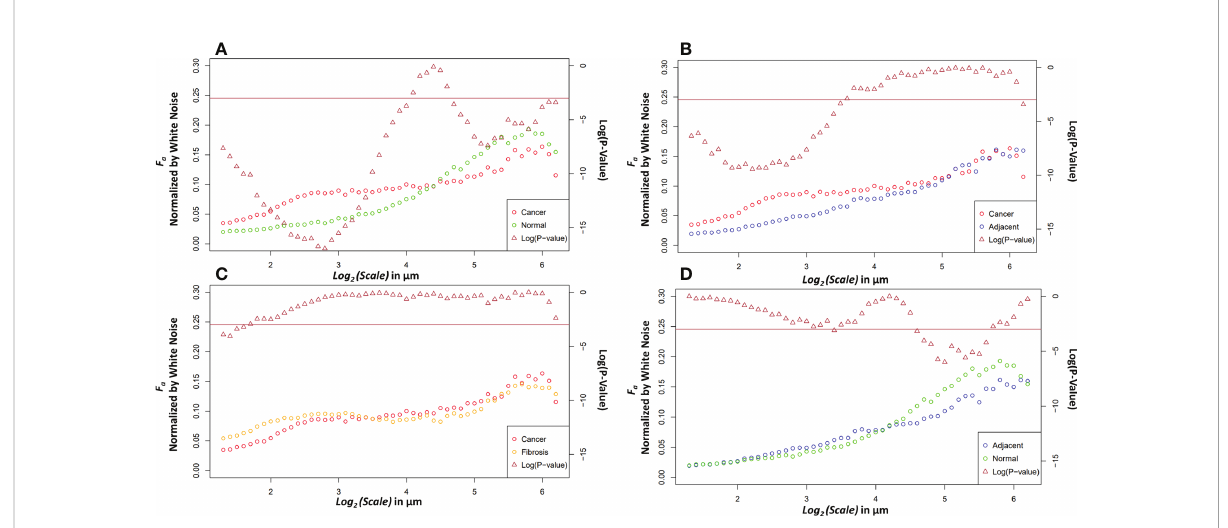
FIGURE 5 Pairwise comparisons of the median anisotropy factor across all images normalized by white noise anisotropy factor from ~2.5 m m to 73.5 m m (left y -axis) for cancer tissue vs. normal tissue (A) , cancer tissue vs . adjacent tissue (B) , cancer tissue vs. fi brotic tissue (C) , and adjacent tissue vs. normal tissue (D) . The p -values (right y -axis), shown in brown, from a Wilcoxon rank sum test ran at each scale between the tissue pair ’ s anisotropy factors. Values below the horizontal brown line at 0.05 show statistical signi fi